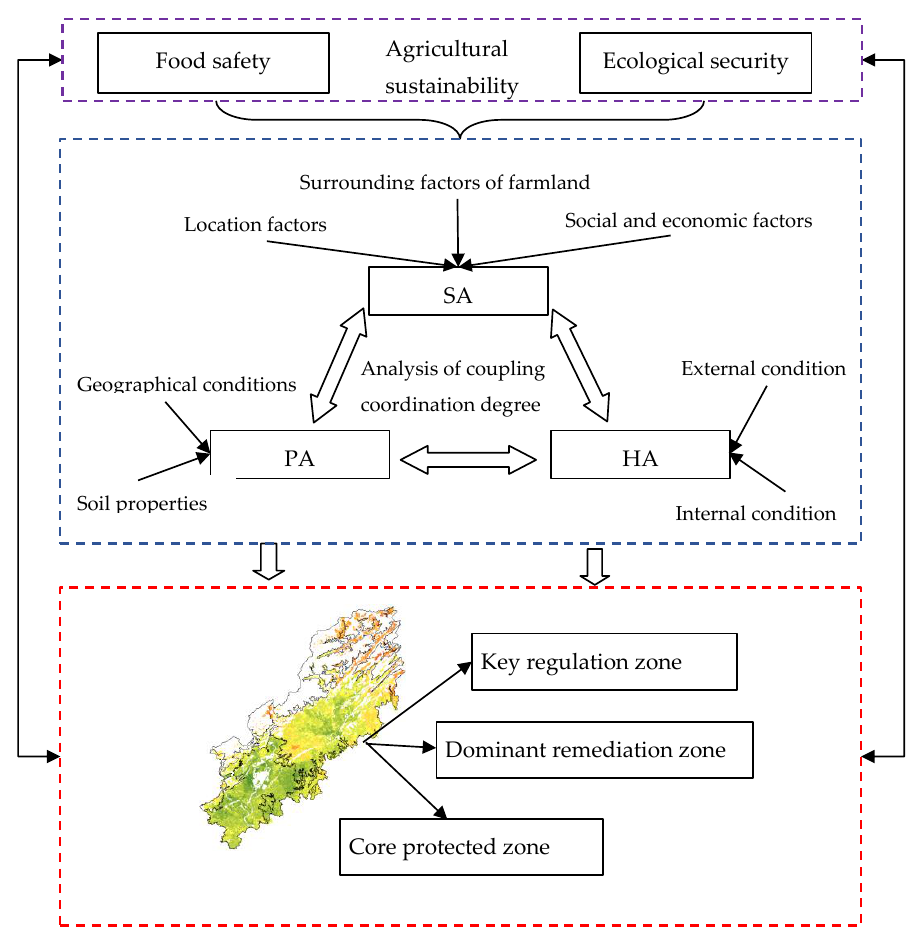
Figure 2. The coupling coordination relationship flow chart of PA, SA, and HA.